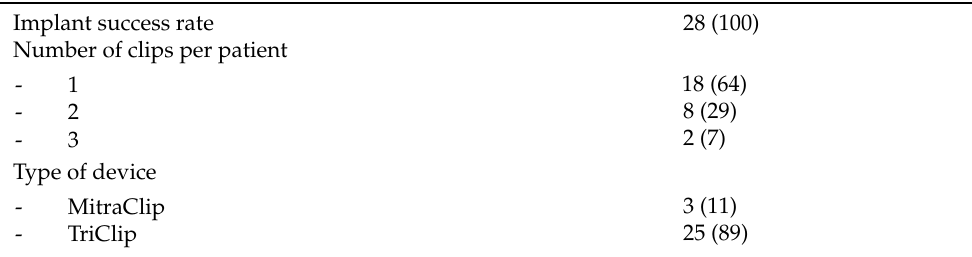
Table 3. Procedure